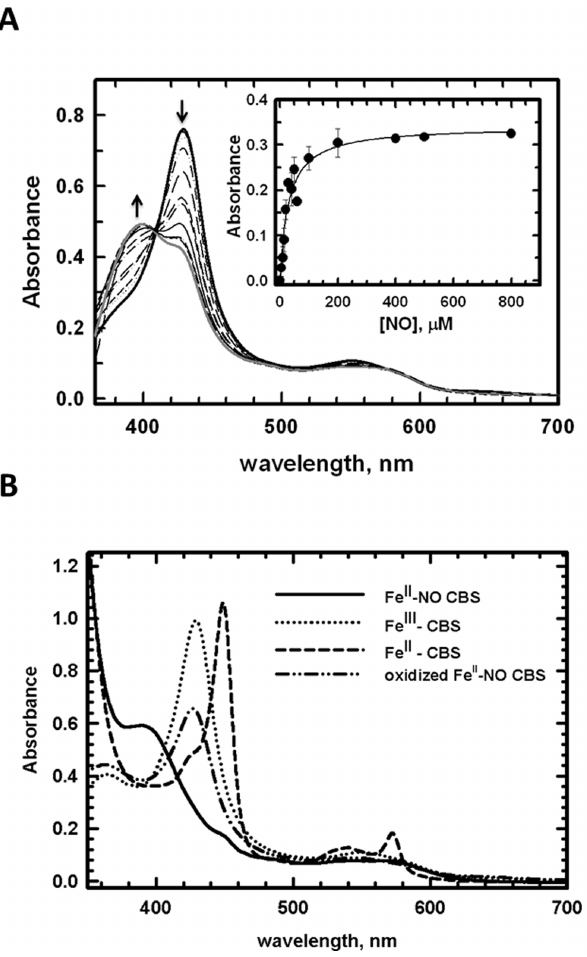
Figure 3. Spectral analysis of reversible NO binding to CBS. ( A ) An anaerobic solution of CBS (10 m M) in 0.1 M HEPES, pH 7.4, was mixed with 250 m M NADPH and 5 m M MSR and varying concentrations (0–533 m M) of diethylamine NONOate in 10 mM NaOH. A sample containing 5 m M MSR and 250 m M NADPH was used as a blank to clarify the region of the spectrum between 350–400 nm. The inset shows the change in absorbance at 428 nm as a function of NO concentration. ( B ) Reversible generation of Fe II -NO-CBS by nitrite reduction. Reduction of Fe III -CBS (10 m M) ( …. ) with dithionite (3 mM) yields Fe II -CBS (–). Reaction of the Fe II -CBS form with nitrite yields Fe II -NO-CBS (–), which can be re- oxidized to Fe III -CBS ( 2 . 2 ).